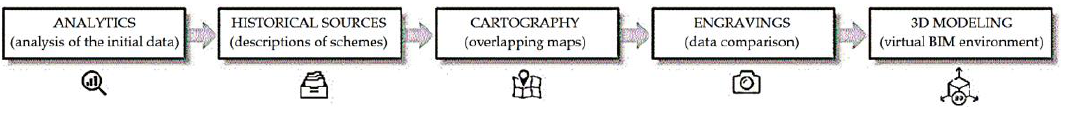
Figure 1. Research stages.